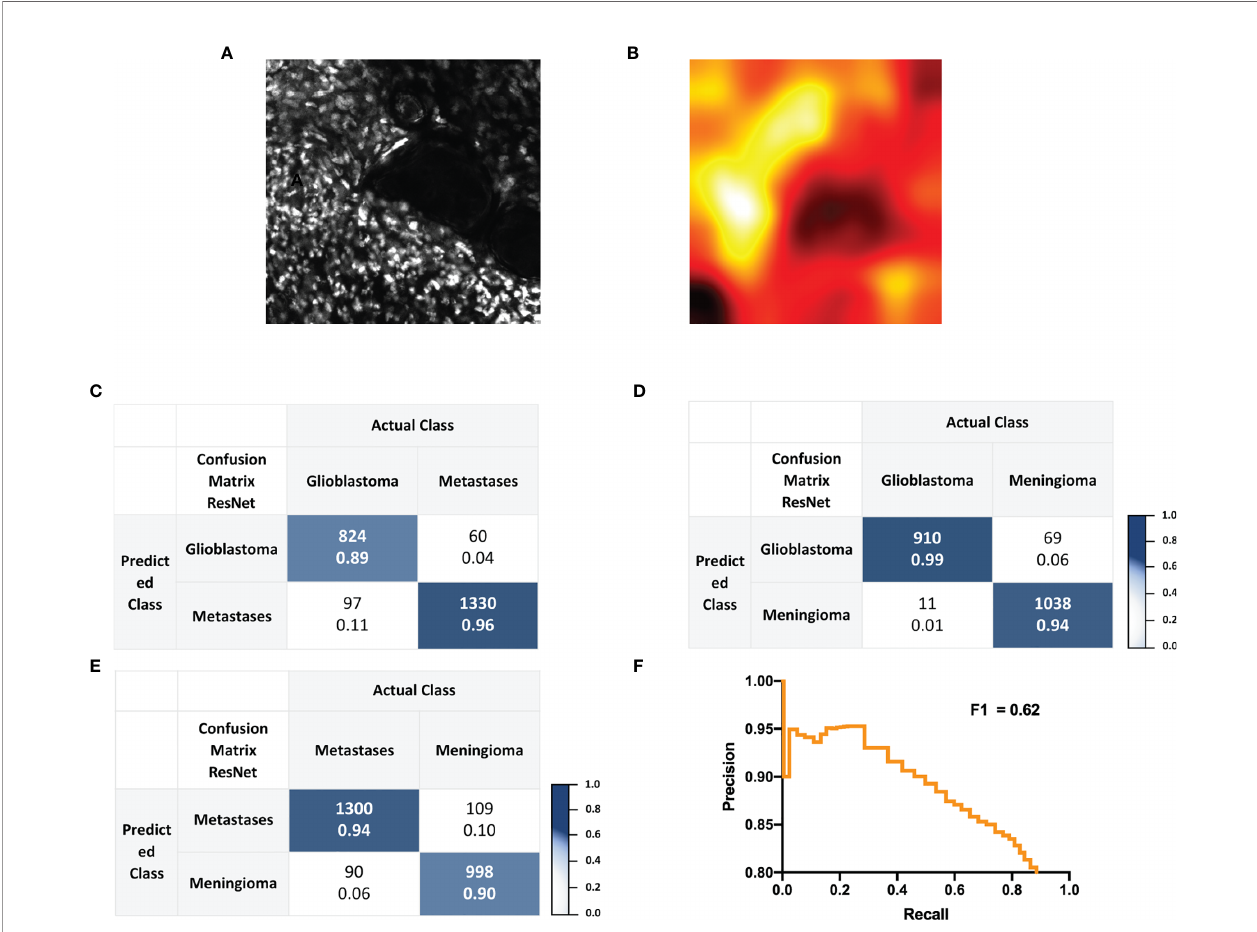
FIGURE 4 | (A, B) Representative glioblastoma CLE image following topical staining with nuclear green and corresponding heat map. (C – E) Confusion matrix for residual network based binary classi fi cation. Images were labeled as “ glioblastoma ” , “ brain metastasis ” or “ meningioma ” and were obtained with CLE following topical ex vivo staining with nuclear green dye. In each cell, the number above is the count and the number below the normalized count. (F) Precision-Recall curve analysis and corresponding macro-averaged F1 score received for a test set of a trained three-class residual